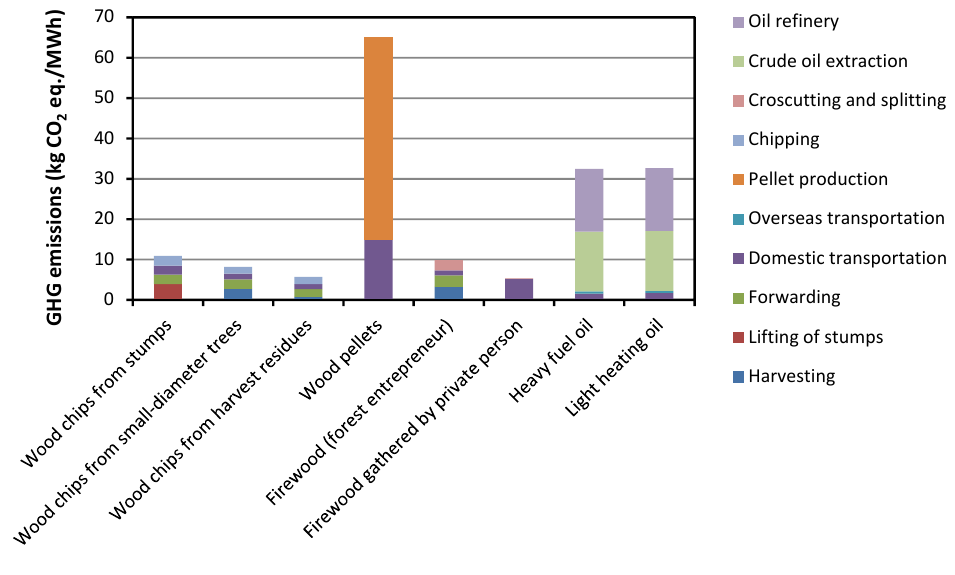
Figure 5. Greenhouse gas emissions (kg CO wood pellet, firewood and oil